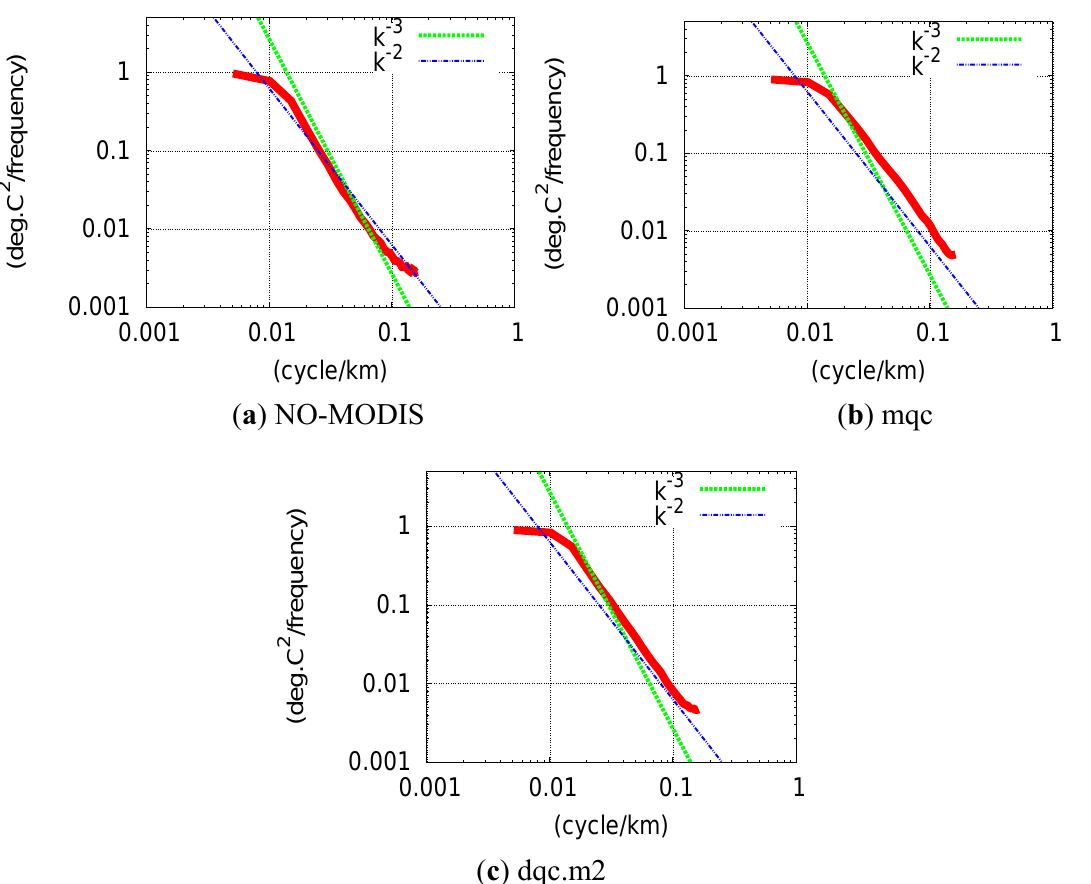
Figure 5. One-dimensional analysis SST spectra (solid curves) along cross-shore direction averaged in the model region south of 33°N and during the period from 8 February to 28 February, 2010. Spectra are normalized by their respective maximum values. The ~k − 3 (~k − 2 ) slopes are displayed by dashed (dashed double-dotted) lines. ( a ) NO-MODIS. ( b ) mqc. ( c )